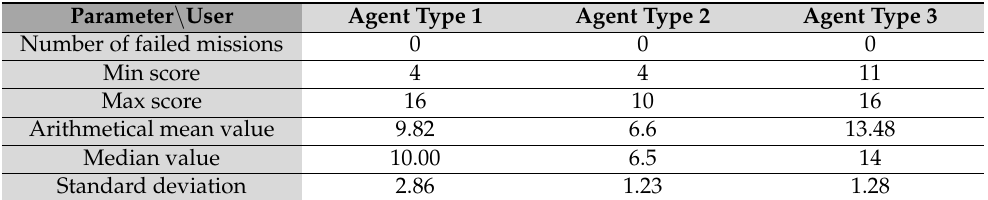
Table 4. Performance data for three agents in a dynamic mode environment, based on the 50 simulation